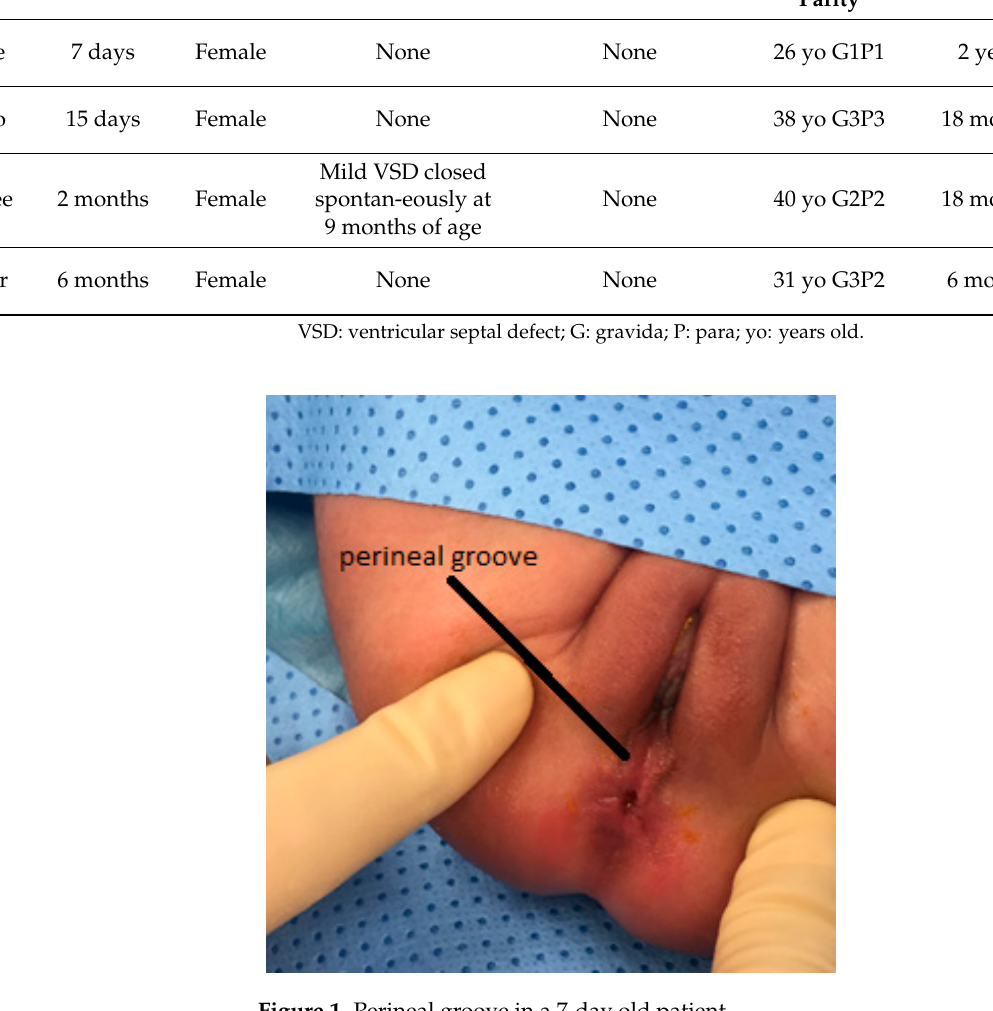
Figure 1. Perineal groove in a 7-day old patient.